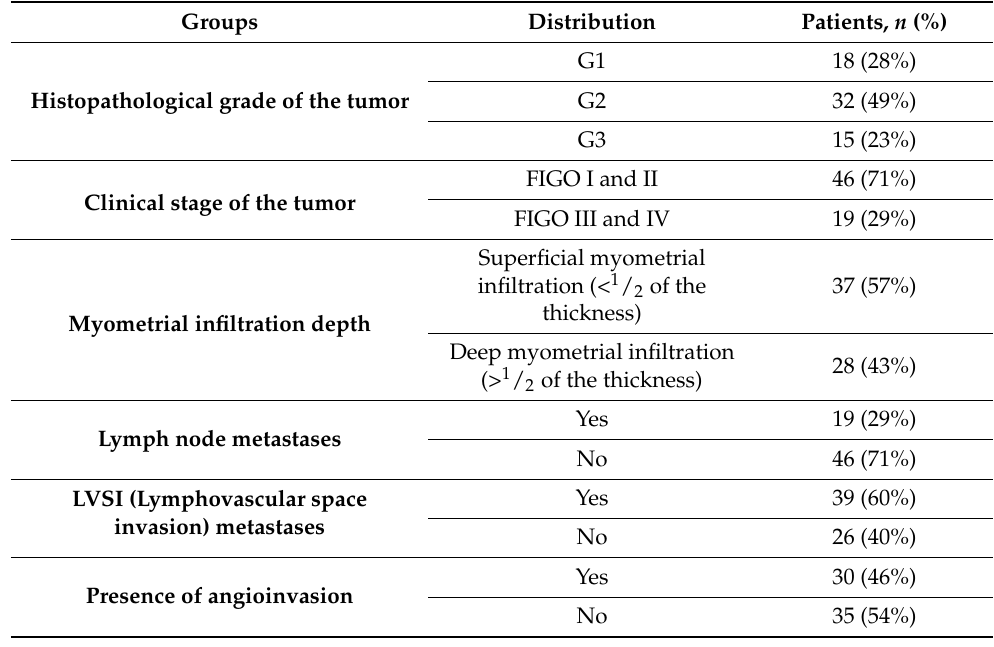
Table 1. Division of endometrial cancer patients: G1–3, grading 1–3; FIGO, International Federation of Gynecology and